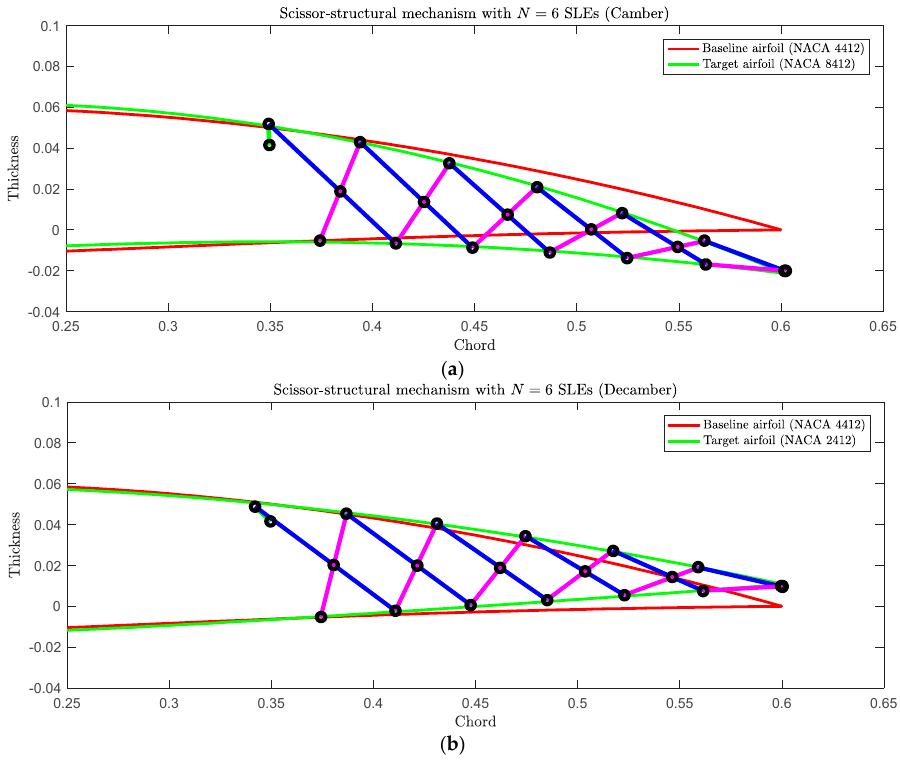
Figure 7. Scissor-structural mechanism with N = 6 SLEs at the deployed position when the target airfoil was: ( a ) NACA 8412; ( b ) NACA 2412.